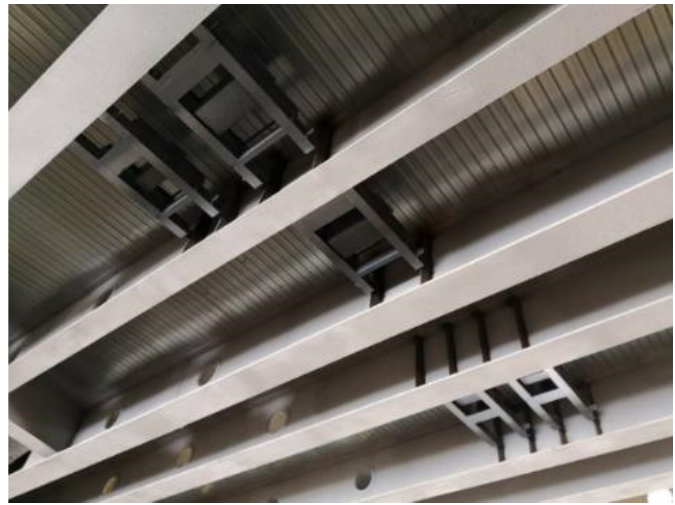
Figure 17. TMDs installed on-site.